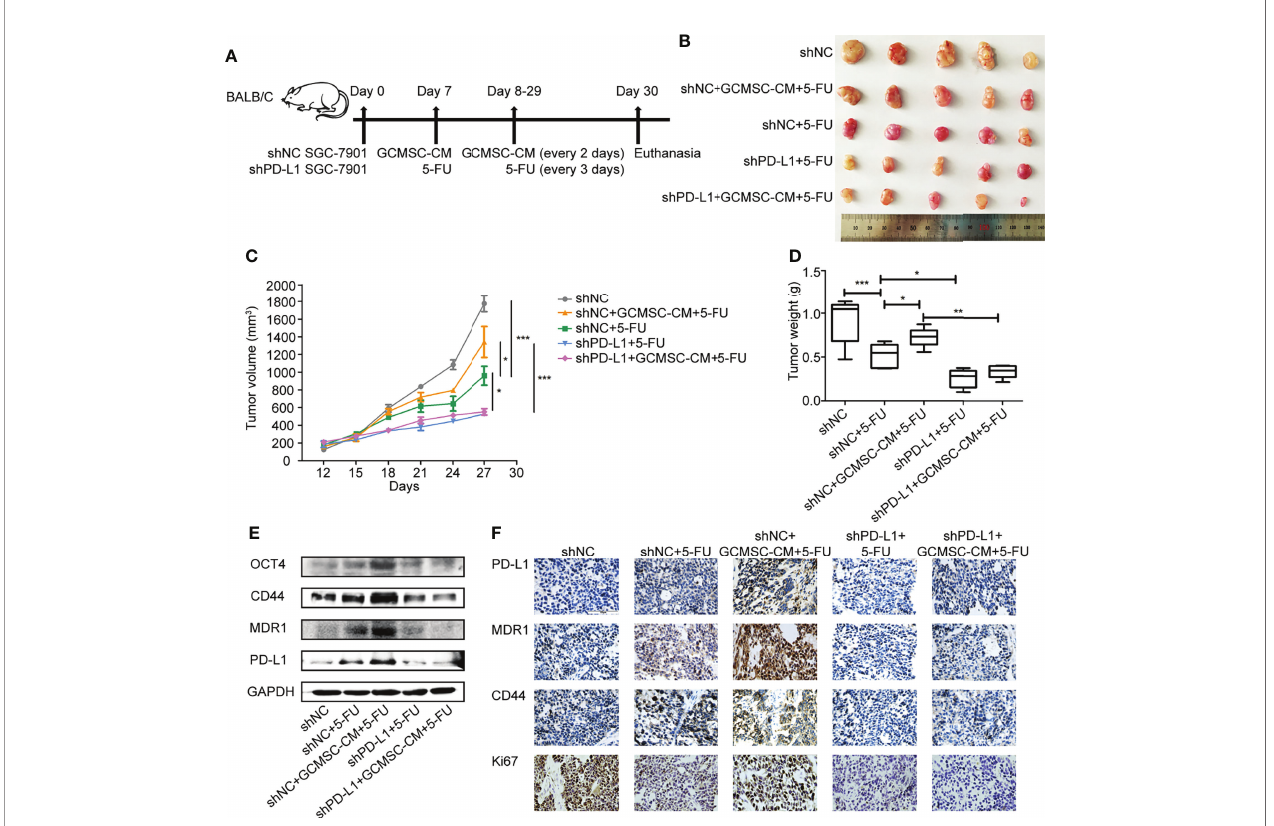
FIGURE 4 | GCMSC-CM reduces sensitivity of mice to 5-FU and PD-L1 knockdown recovers it. (A) Schematic representation of in vivo experiment. (B) Representative images of tumors from the indicated group. (C) Tumor volumes of SGC-7901 xenografts in mice. (D) Comparison of tumor weights in each group on day 30. (E) Expression of PD-L1, MDR1, CD44, and OCT4 in SGC-7901 xenograft tissues from different treatment groups was detected via Western blot. (F) Expression of PD-L1, MDR1, CD44, and Ki67 in SGC-7901 xenograft tissues was detected by immunohistochemistry (scale bar: 100 m m). * p < 0.05, ** p < 0.01, *** p <